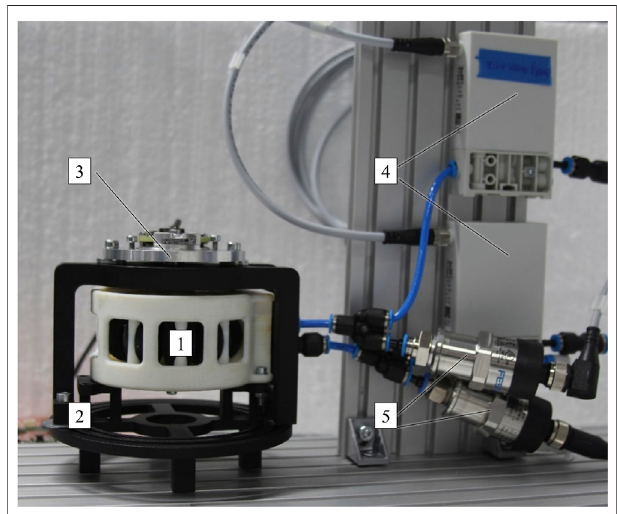
FIGURE 12 | Experimental setup for investigating the time-dependent structural behavior of pneumatic rotary bellows actuators.